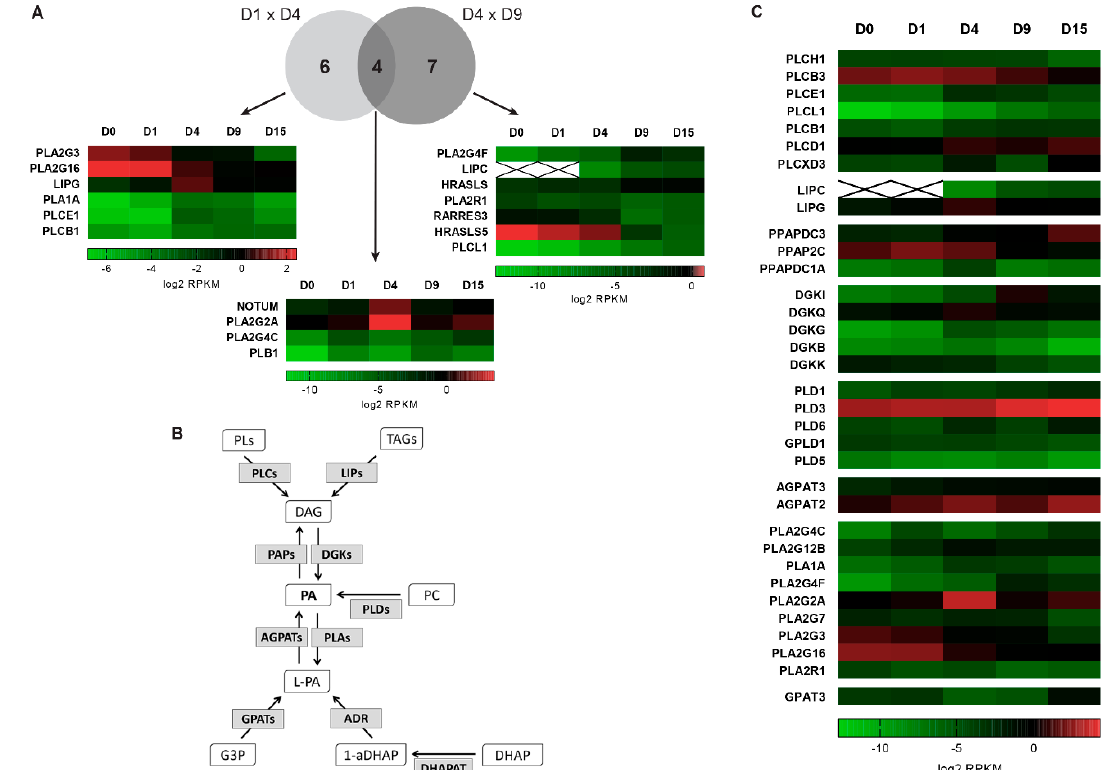
Figure 6. Lipid metabolism-related genes regulated in in vitro cardiac differentiation. ( A ) Comparison of genes identified in the “phospholipase” canonical pathway at D1 × D4 and D4 × D9. Venn diagram showing the number of DEGs. ( B ) Scheme of phosphatidic acid (PA) metabolism (Adapted from [84]). ( C ) Heatmaps representing the gene expression profiles (log2 RPKM values) of DEGs related to PA metabolism.